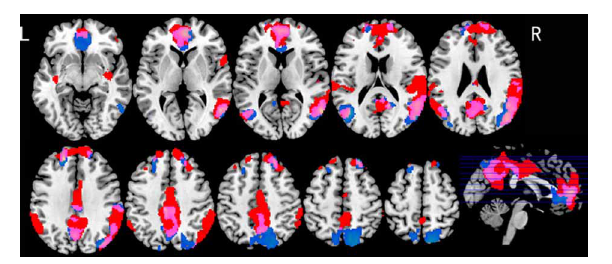
FIGURE 2 | Brain activation maps for both visual and auditory tasks. Blue indicates activations for visual tasks; Red indicates activations for auditory tasks; Purple indicates overlapping activations for both tasks. p < 0 . 05, FDR corrected, greater than 10 voxels.